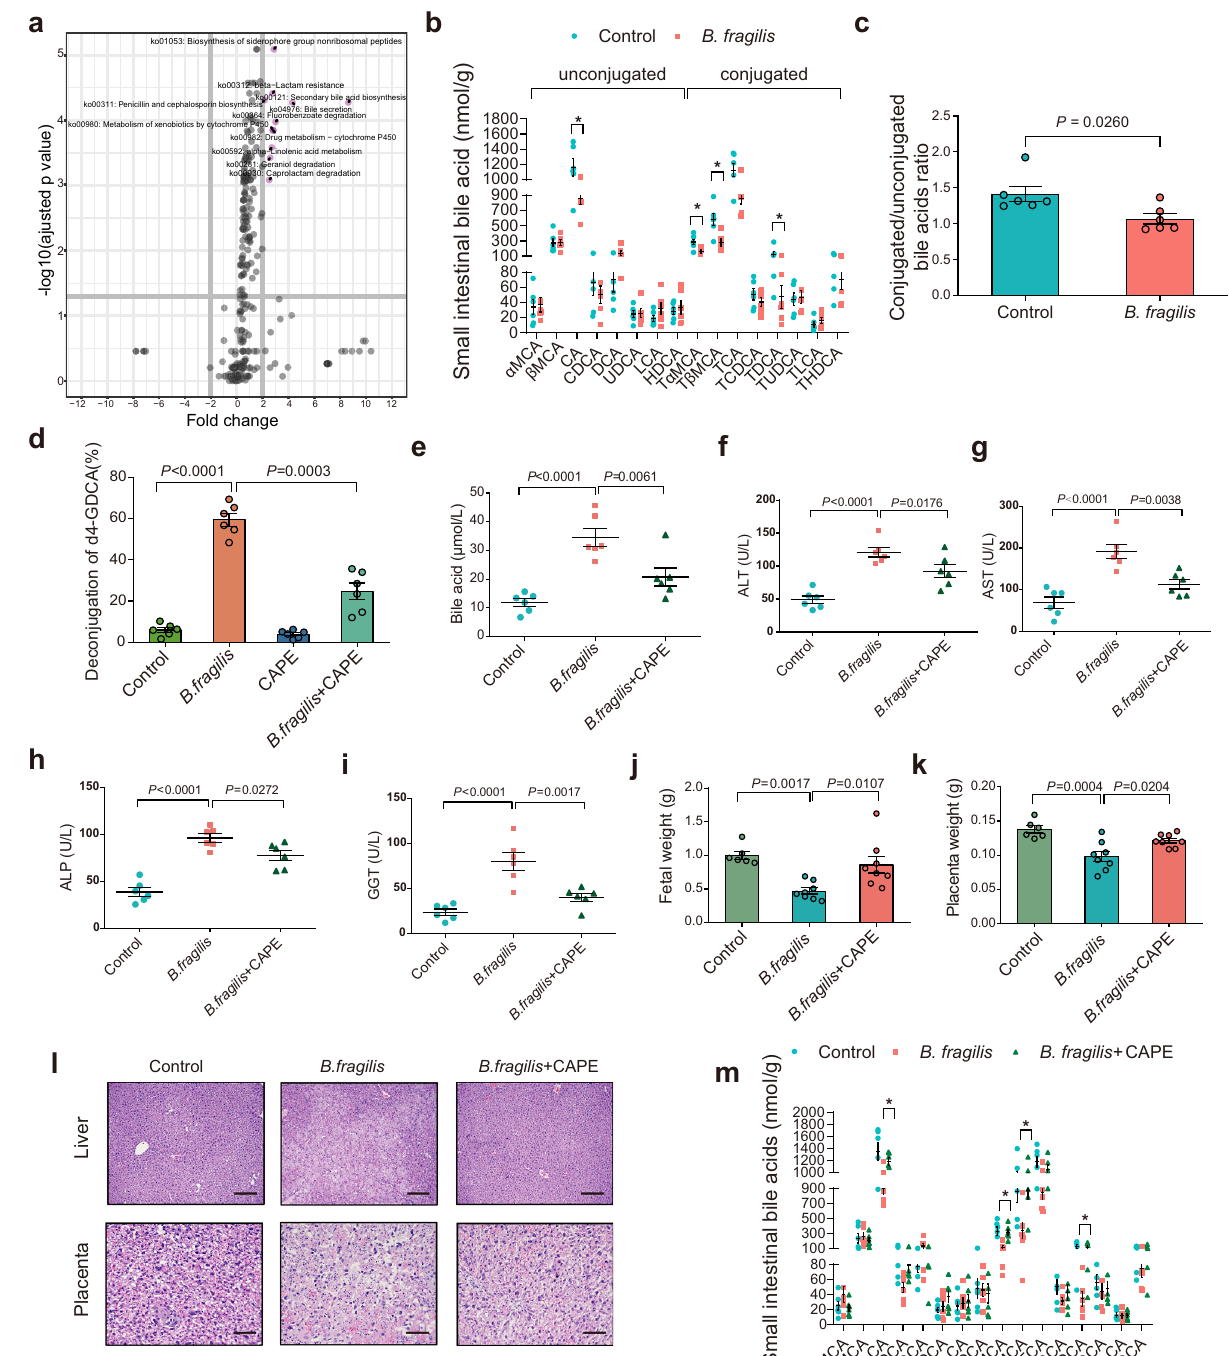
Fig.3| B.fragilis promotestheICPthroughitsBSHactivitymediatingbileacid metabolism. a Kyoto Encyclopedia of Genes and Genomes (KEGG) annotation of key altered metabolic pathways in individuals with ICP. P values were adjusted by Benjamini & Hochberg (BH) method to control FDR. FDR-adjusted P <0.05 was shown. b Levels of small intestinal bile acids in B. fragilis transplanted mice or control group ( n =6 mice per group). P values were determined by two-tailed Student ’ s t -test. * P <0.05. c Conjugated and unconjugated bile acids in B. fragilis transplanted mice or control group. n =6 per group. P values were determined by two-sidedMann – Whitneytest. d Hydrolysisef fi ciencyofGDCAby B.fragilis withor without CAPE in vitro. P values were determined by Welch ANOVA with Games- Howell ’ s multiple comparisons test. n =6 per group. e – i Mice were divided into